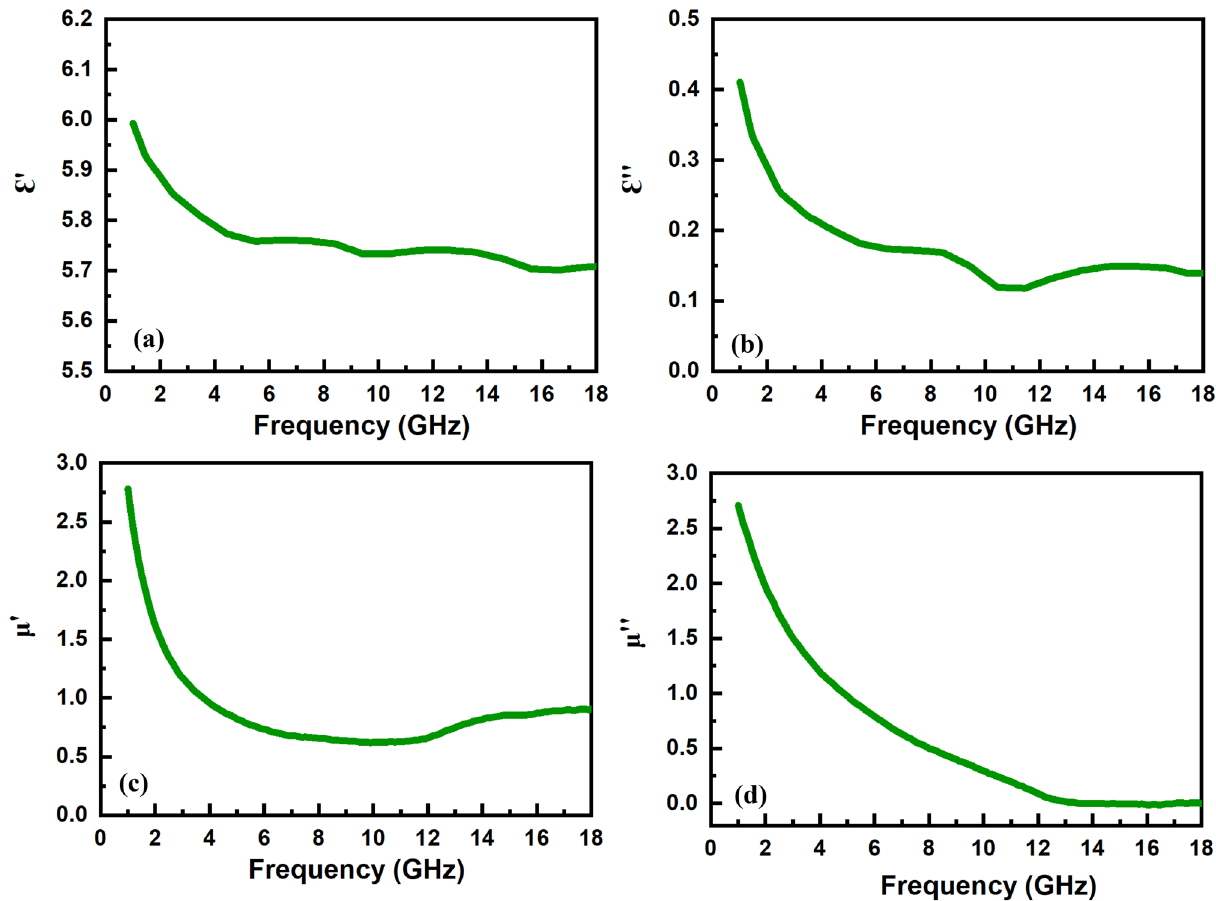
Figure 7. Permittivity and permeability spectra of the sample sintered at 1300